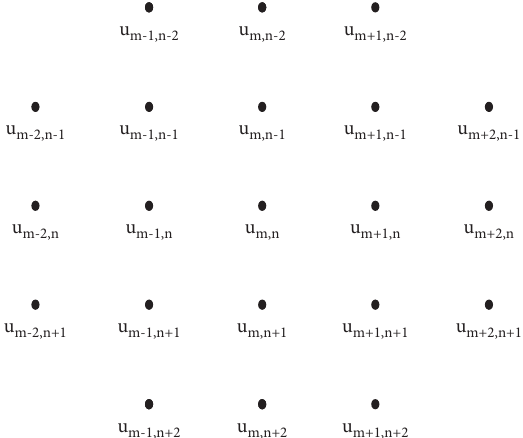
Figure 1: The 21-point finite difference stencil with